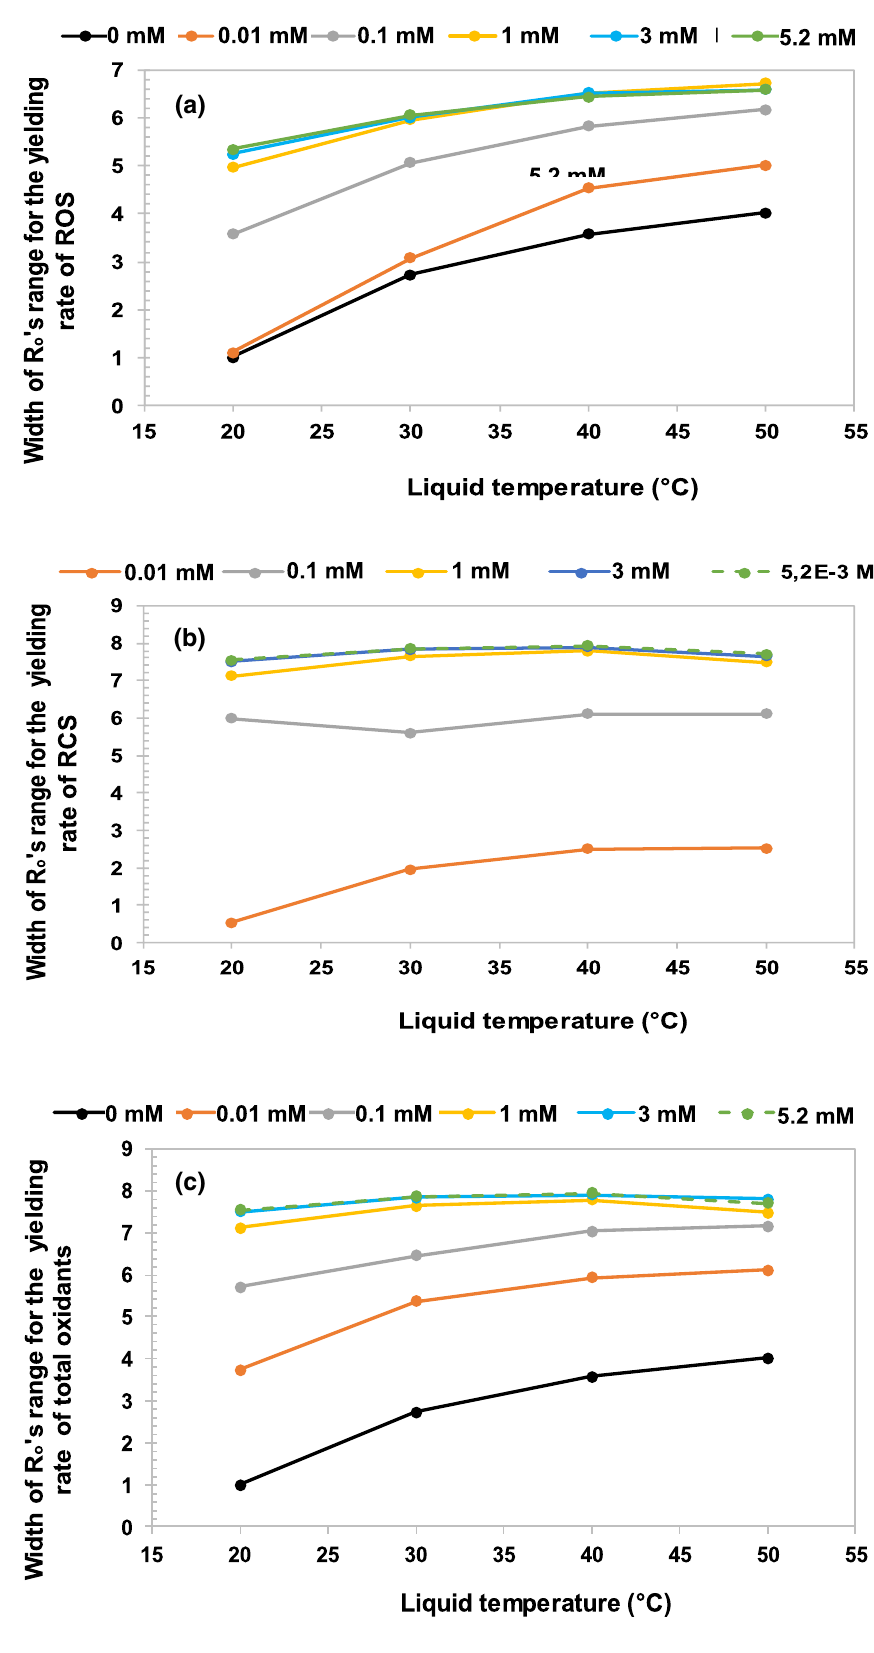
Fig. 4 Broadness of active bubbles range (according to Table 1) for the maximal production rate of a ROS ( • OH, O, O 3 , HO 2• and H 2 O 2 ), b RCS ( • CCl 3 , : CCl 2 , • Cl, Cl 2 , HOCl) and c all oxidant (ROS + RCS) as a function of liquid tem- perature (20–50 °C) and CCl 4 concentration (0–5.2 mM). Sim- ulation conditions: